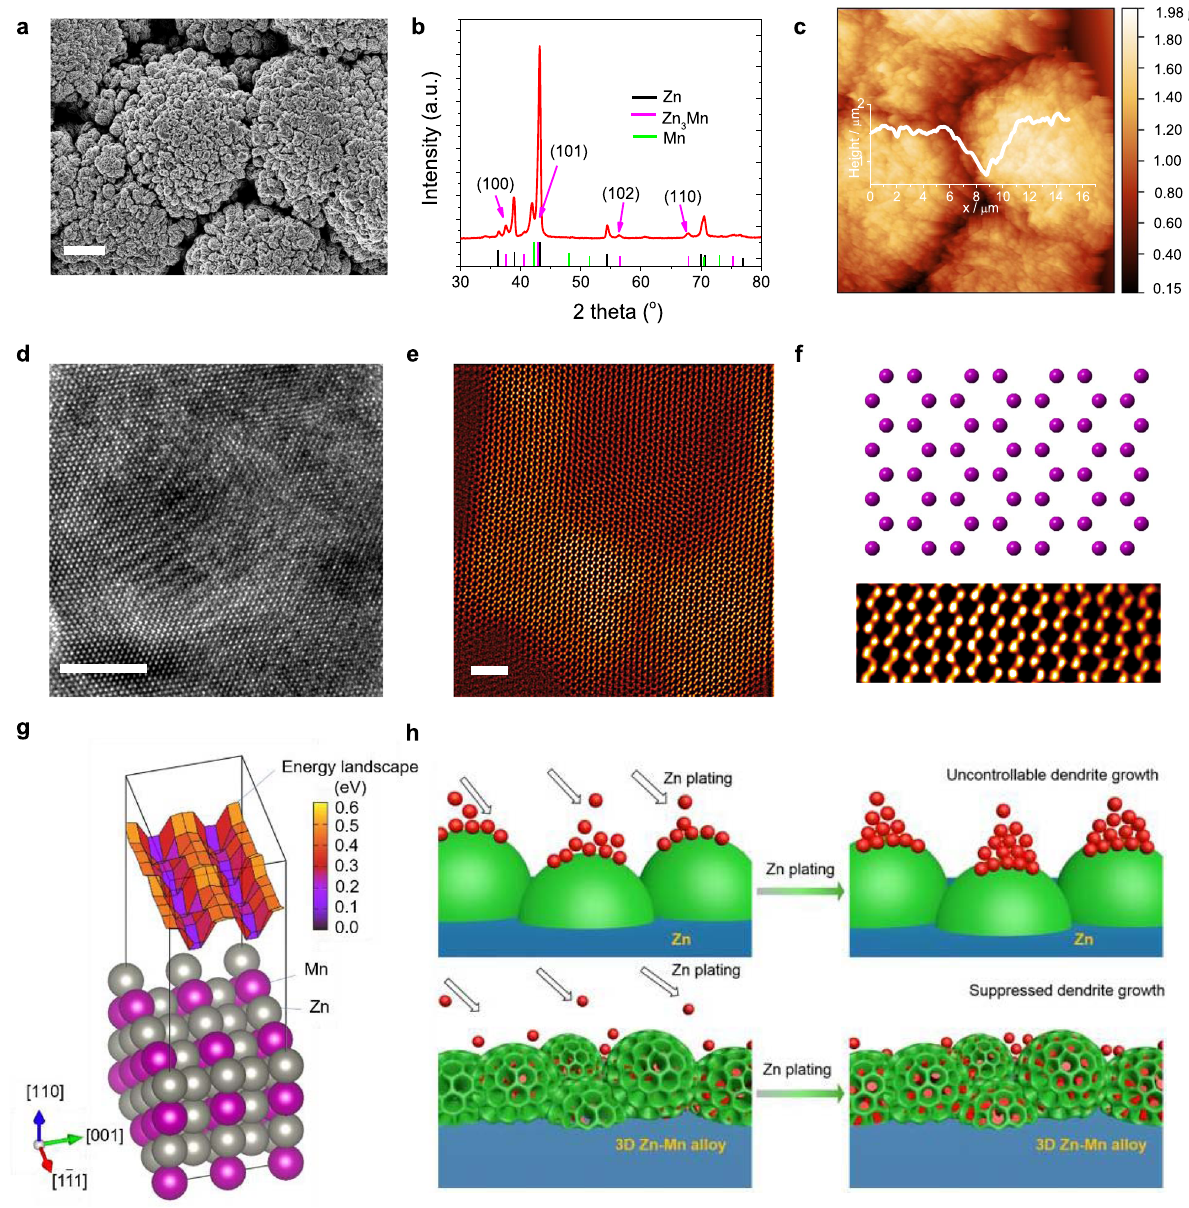
Fig. 1 Preparation and characterizations of the Zn-Mn alloy anode. a SEM image. The scale bar: 10 μ m. b XRD pattern. c AFM image. d HRTEM image of Zn 3 Mn viewed along [001] direction. The scale bar: 10 nm. e , f HAADF-STEM image and the corresponding atomic crystal structure. The scale bars: 2 nm. The purple balls in the crystal structure model represent the co-occupied Zn/Mn atoms. g Atomic structure and the surface ad-atom energy landscape of Zn 3 Mn. h Schematic illustration of Zn plating processes on Zn anode (top) and Zn-Mn anode